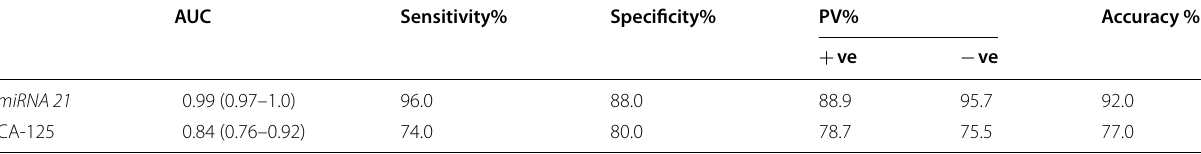
Table 6 Validity of miRNA 21 expression and CA-125 serum level as diagnostic markers of ovarian cancer